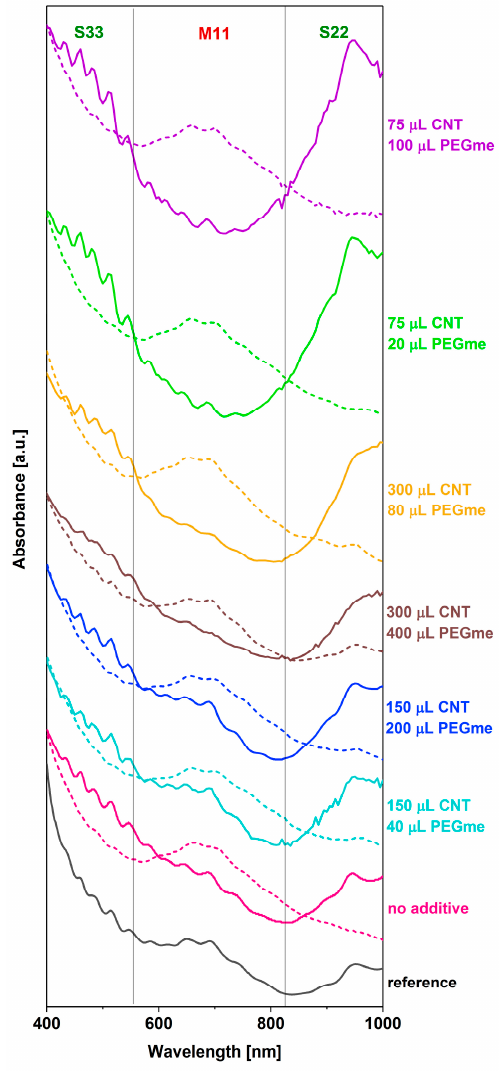
Figure 6. The influence of the volume of the CNT dispersion and hydration modulating agent (PEGme) in the ATPE system on the course of the separation. Dextran-rich bottom phase (dashed line), PEG-rich top phase (solid line).